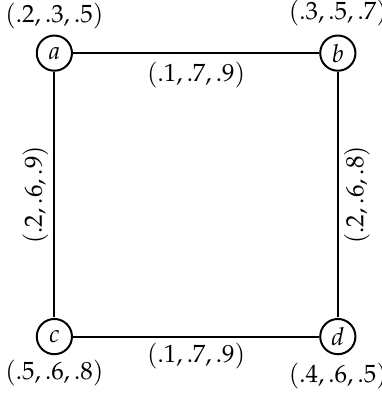
Figure 2. A neutrosophic graph G